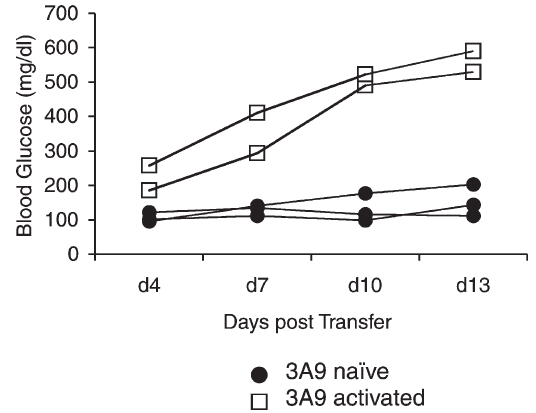
FIGURE 1 Naı¨ve 3A9 T cells fail to induce diabetes upon transfer to RIP-HEL recipients unless previously activated in vitro . 5million naı¨ve or in vitro activated 3A9 þ T cells were transferred to RIP-HEL mice. Blood glucose readings are shown at the indicated time post adoptive